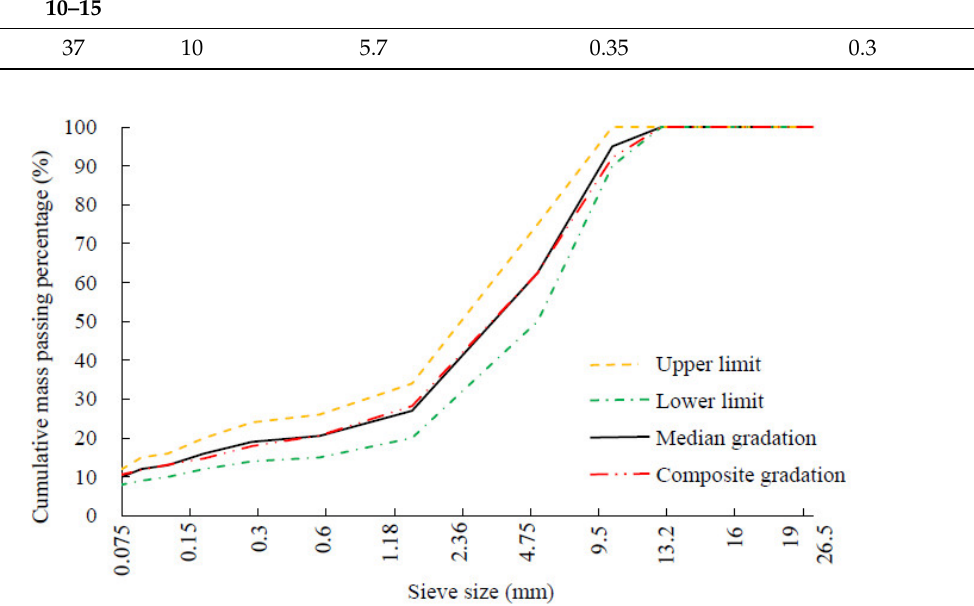
Figure 1. Production grading curve.